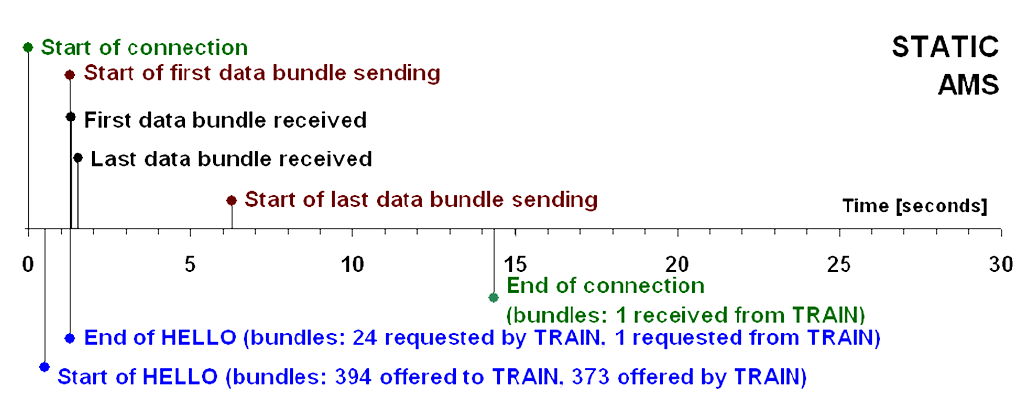
7 Future improvements for the overall solution in the Postojna